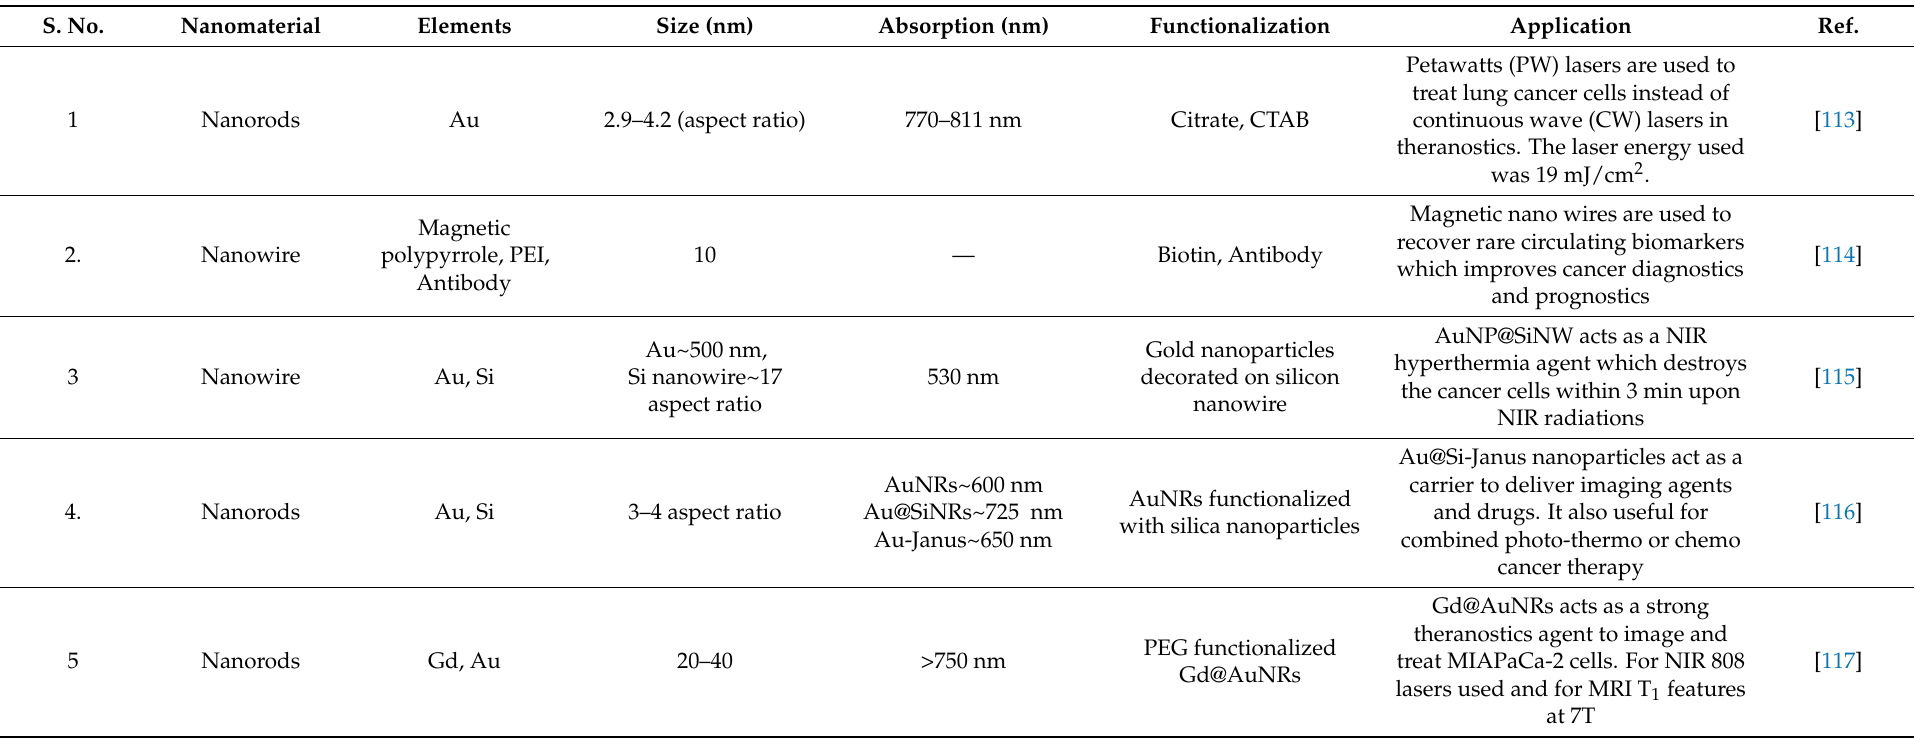
Table 2. Summarizes the list of 1D nanomaterials employed in theranostics